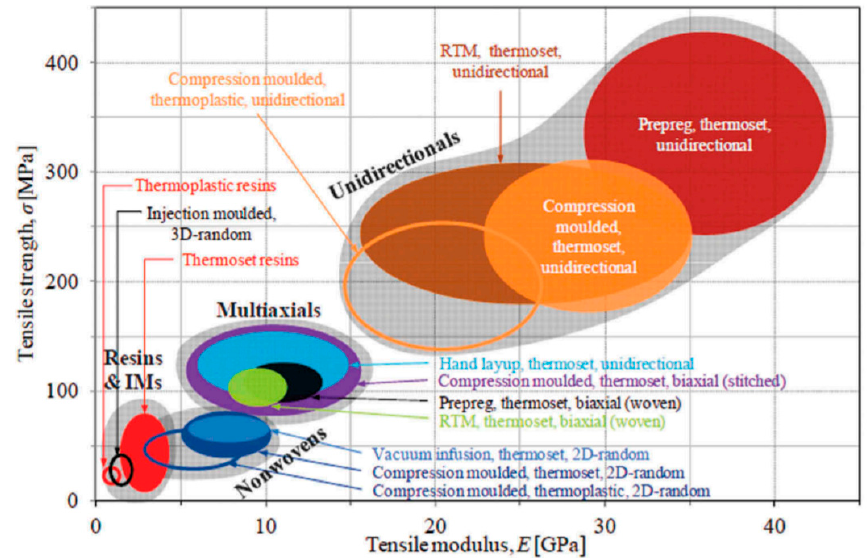
Figure 3. Typical tensile properties for plant fiber reinforced plastics manufactured with thermoplastic / thermoset resins, short-random / long-aligned fiber reinforcements, and various manufacturing processes (reproduced from [145]). RTM = resin transfer moulding, IM = injection moulding. Molecules 2020 , 25 , x FOR PEER REVIEW